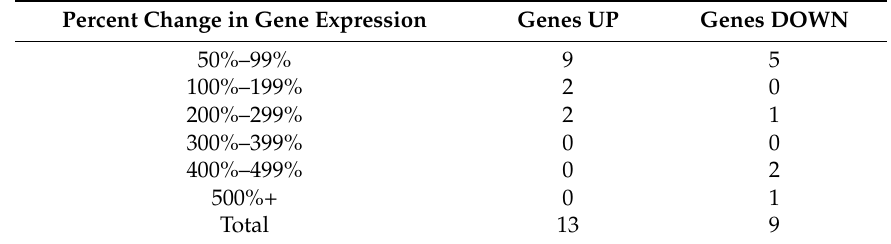
Table 13. Distribution of Genes Affected by GHK and Associated with Motor Neurons.